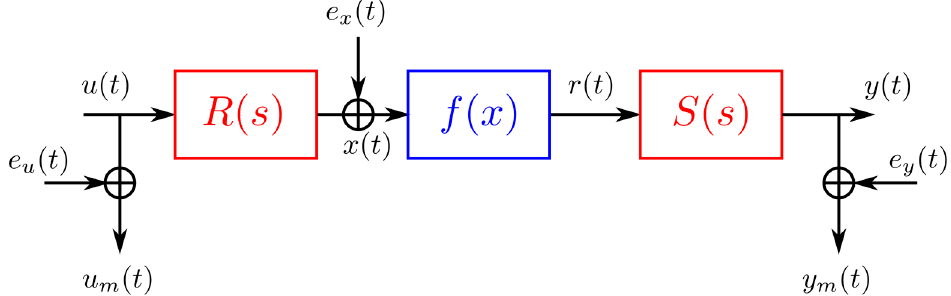
Figure 1. A Wiener–Hammerstein system with process noise: the red blocks represent linear time-invariant dynamics, while the blue block represents a static nonlinearity [7].